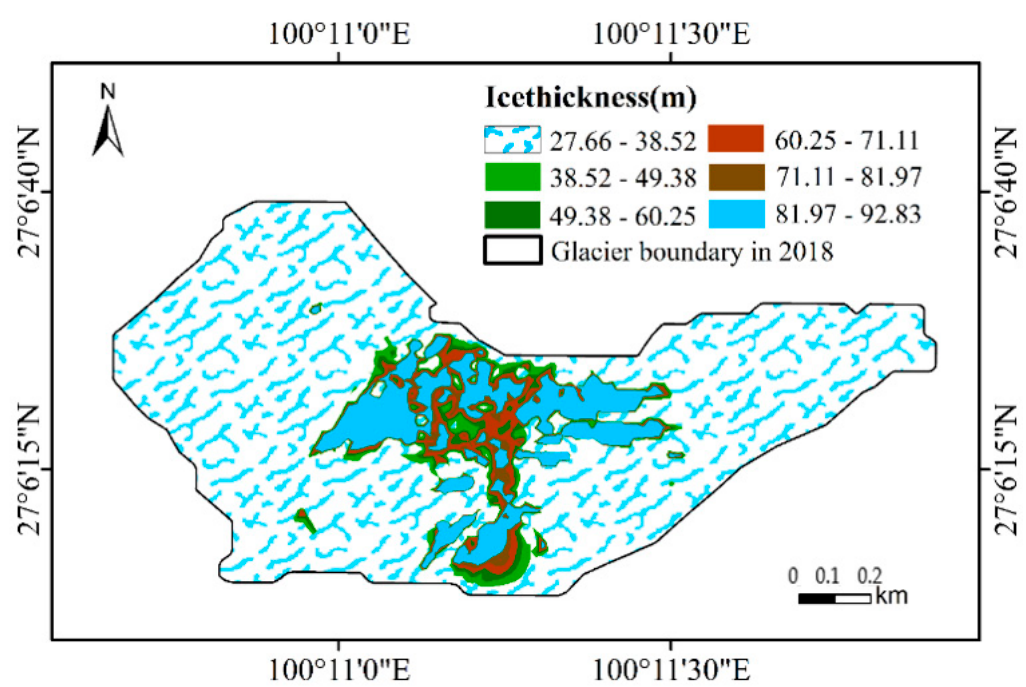
Figure 6. Kriging interpolation of the ice thickness distribution in the mid-part of BRG1 in Mt. Yulong. The ice thickness contour map (Figure 7) with a gradient of 5 m was extracted from the interpolation distribution graph of the central area at BRG1 [8,10–13]. The glacier can be divided into north and south parts by the exposed surface until the middle part. In the interpolation results, the measurement of the ice thickness in the north area was covered by more points while the measured points in the south area were less. According to their distribution features at different elevations, the ice thickness of the glacier in this region ascends in three steps (Figure 7).